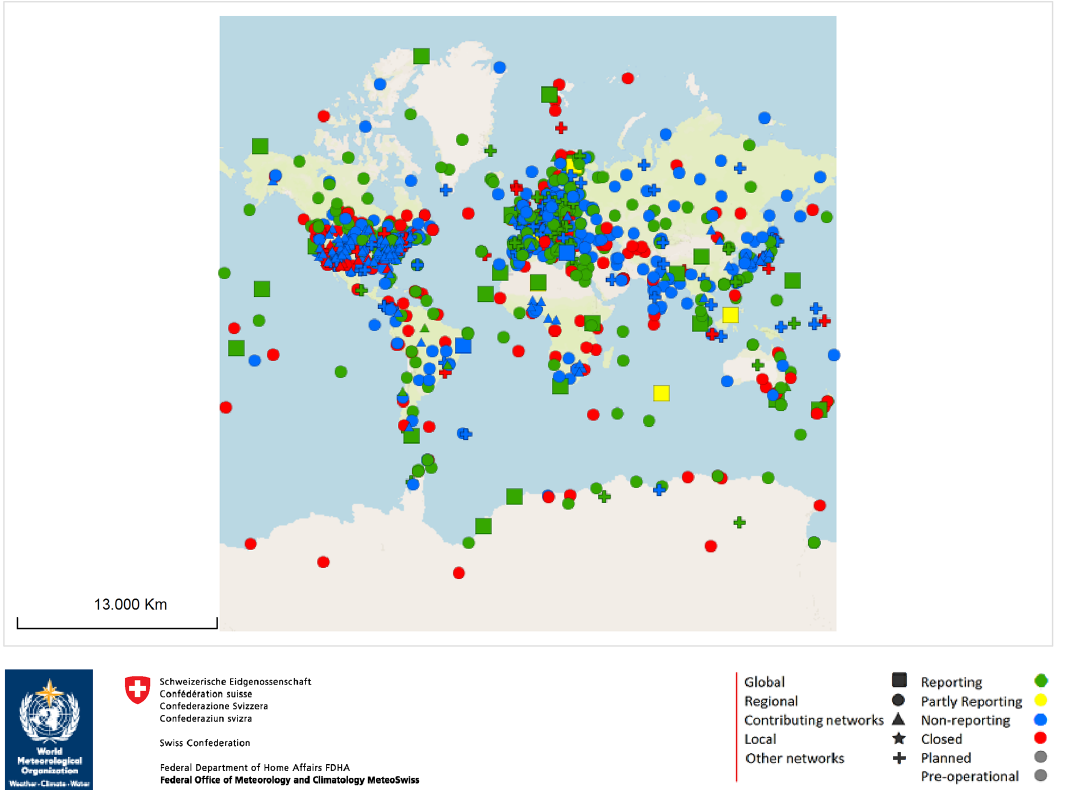
Figure 1. Map of surface stations currently included in GAWSIS. Figure courtesy of